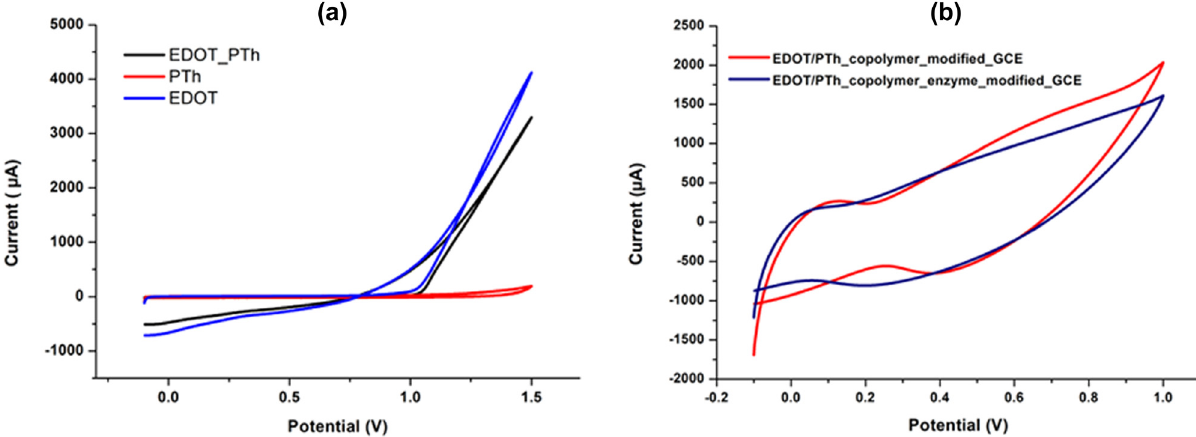
Figure 4: ( a ) Cyclic formation voltammograms of PEDOT, PTh and EDOT/Th copolymer. ( b ) Cyclic voltammograms of copolymer - modi fi ed and enzyme immobilized copolymer - modi fi ed GC electrodes with 50 mV/s scan rate in the bu ff er